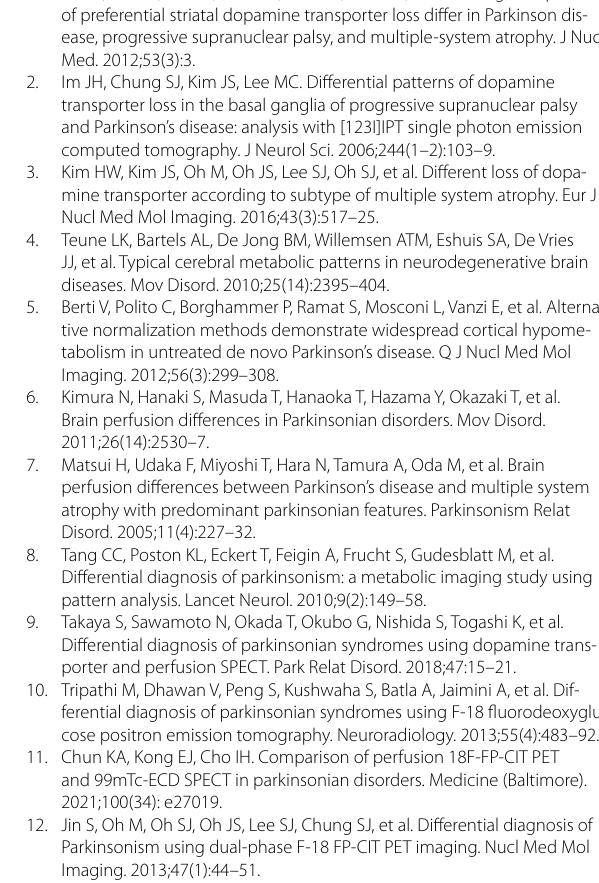
Additional file 5 : Table s2 . Cerebral flow in the striatum. Healthy controls vs. patients with reduced specific DAT activity in the striatum.